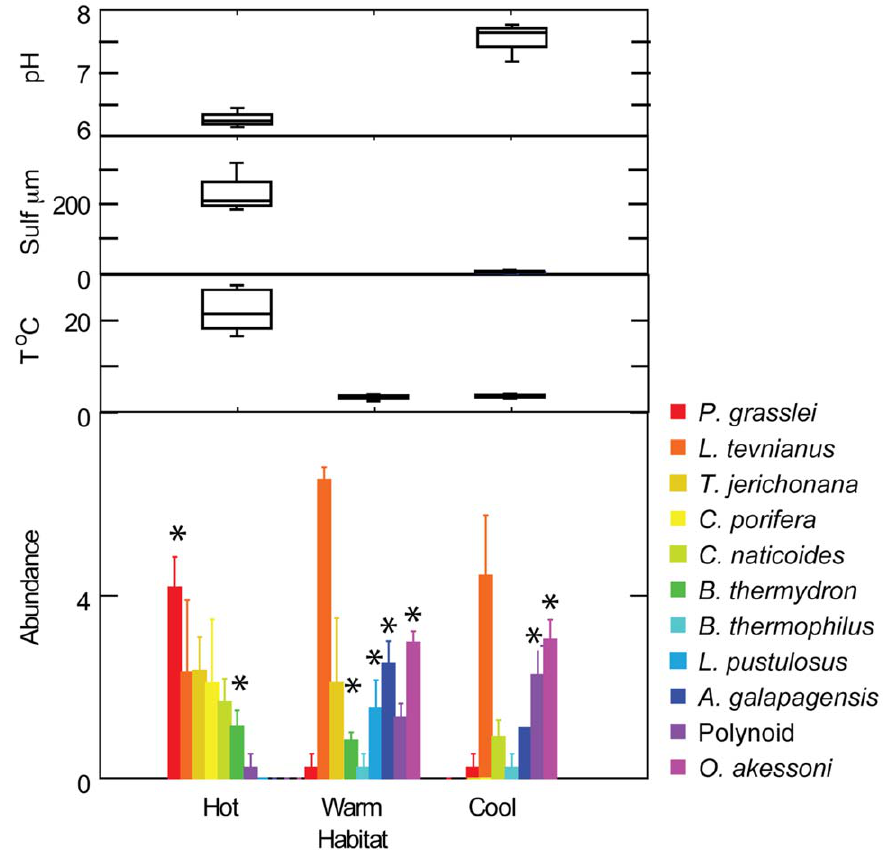
Figure 7. Variation of fauna and fluid environment with habitat at P-vent. Abundance (mean and standard error; log transformed) of selected species in hot, warm and cool habitat at 11 months. Asterisk denotes abundance significantly greater than one or both other conditions (Table S3). Environmental conditions are displayed as box plots (median, quartiles, range) measured in vicinity of colonization surfaces with Alvin T- probe and electrochemical sensors coupled with